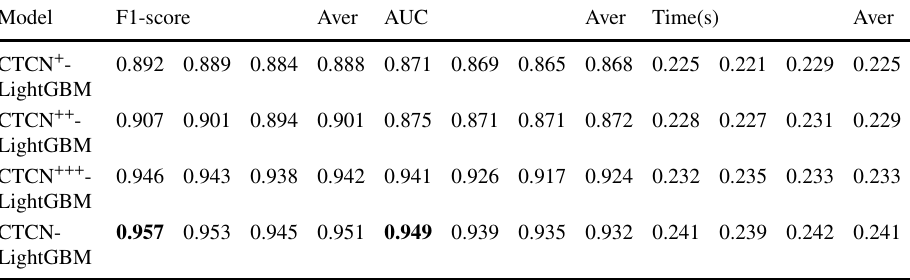
The bold values indicate superior metric values of the proposed CTCN-LightGBM convolutional kernel size is 2. The LeakyReLU value is the hidden layers are 32/16, and the training epoch is 0.3, and the batch normalization value is 0.9. Addition- 800. ally, the feature dimensionality reduction ratio is 0.25, 2. Light-GBM: The number of trees is 500, the maximum depth is 6, the model learning rate is 0.01, the bagging